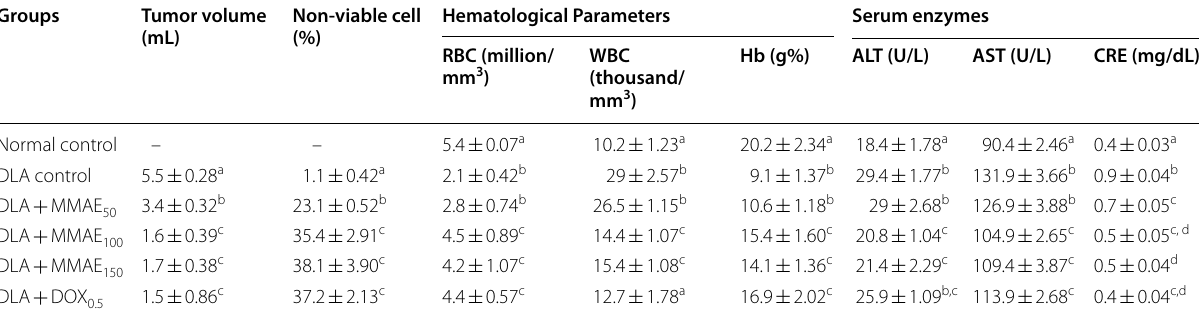
Normal Control: Healthy mice without treatment; DLA Control: DLA bearing mice without treatment; DLA mice treated with 50, 100 and 150 mg/kg b.wt of aqueous extract of M. macrophylla ; DLA Values are mean SEM ( n 6) ± = Different letters indicate significant variation at p < 0.05